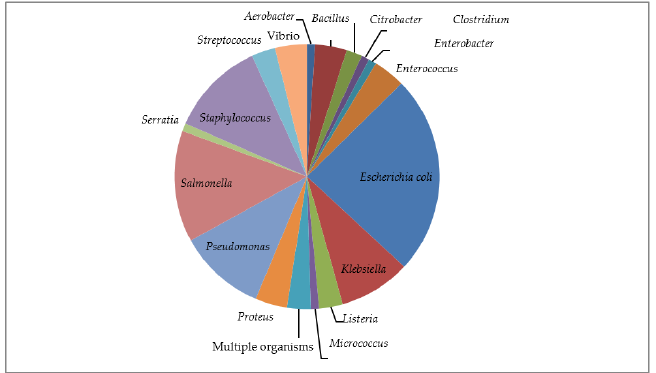
Figure 1. Distribution of organisms studied in the antimicrobial resistance studies based on reports.